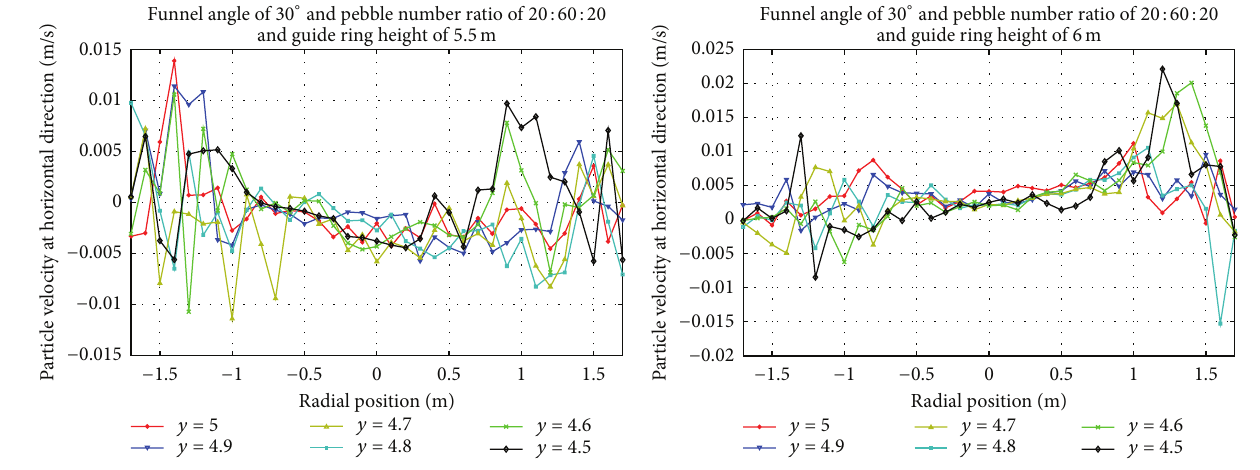
(a) Horizontal velocity distribution of pebbles with guide ring of 5.5m at upper region mFunnel angle of 30 ∘ and pebble number ratio of 20 : 60 : 20 and guide ring height of 5.5